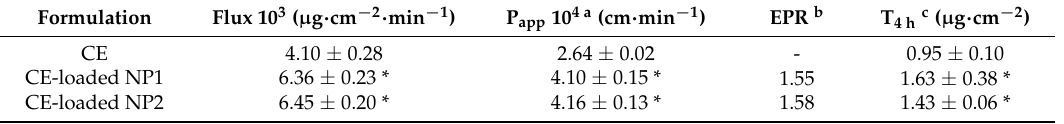
Figure 2. CE apparent permeation plots across excised rat intestine. CE = cherry extract; NP1 = NPs based on quaternary ammonium chitosan; NP2 = NPs based on quaternary ammonium S-protected thiolated chitosan; GAE = gallic acid equivalent. Table 2. Data on CE permeation across excised rat jejunal epithelium from phosphate buffer (PB, PH = 7.4) containing CE alone or encapsulated in NPs (15.5 µ g/mL gallic acid equivalent